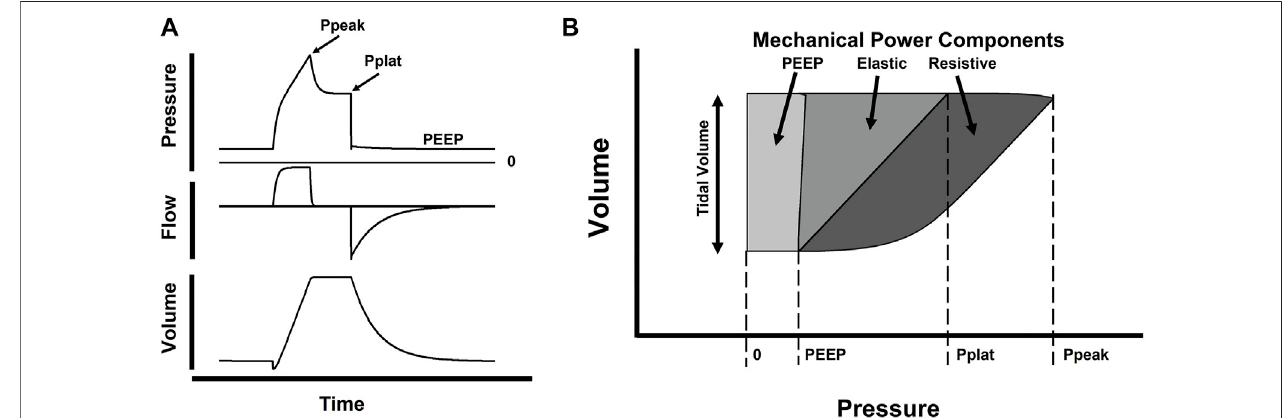
FIGURE3| SchematicrepresentationofMechanicalPower.Inpanel (A) wedisplayasinglebreathofapatientventilatedwithVolumeAssistControl.Graphsshow changes in Pressure, Flow and Volume over time and highlight points ofinterest: PEEP, peak pressure (Ppeak) and plateau pressure (Pplat, at end of inspiratory pause). In fi gure (B) ,wedisplayaVolume-Pressureloopwiththesamepointsofinterestobservedinpanel (A) .DarkgrayarearepresentsResistiveMechanicalPower,changein pressuretoovercomeresistiverespiratoryforcesintegratedoverchangeinvolume(tidalvolume);middlegrayarearepresentsElasticmechanicalpower,changein pressure to overcome elastic respiratory forces integrated over change in volume; light gray area represents PEEP mechanical power, a static component of pressure representing baseline tension on the respiratory system also integrated over change in tidal volume. (Adapted from Silva et al., 2019).